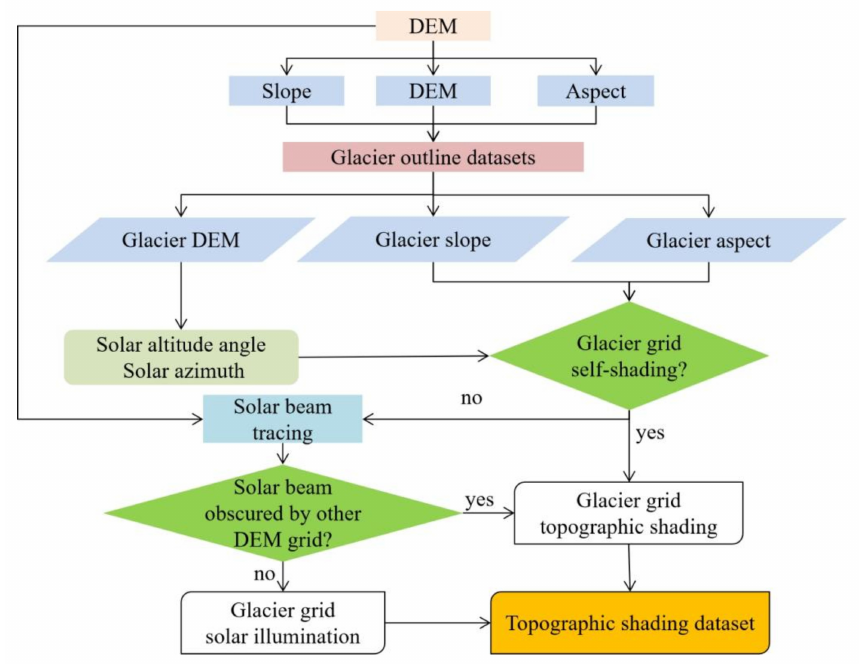
Figure 2. Work flow for topographic shading